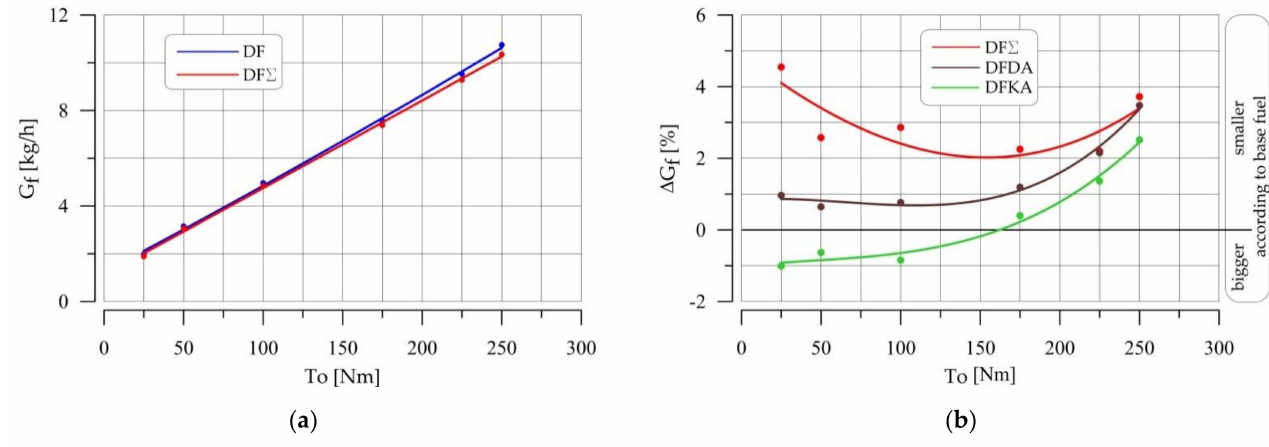
Figure 6. ( a ) Hourly fuel consumption (G f ) vs. engine torque; ( b ) Percentage difference in the values of hourly fuel consumption ( ∆ G f ) vs. engine torque in relation to the base